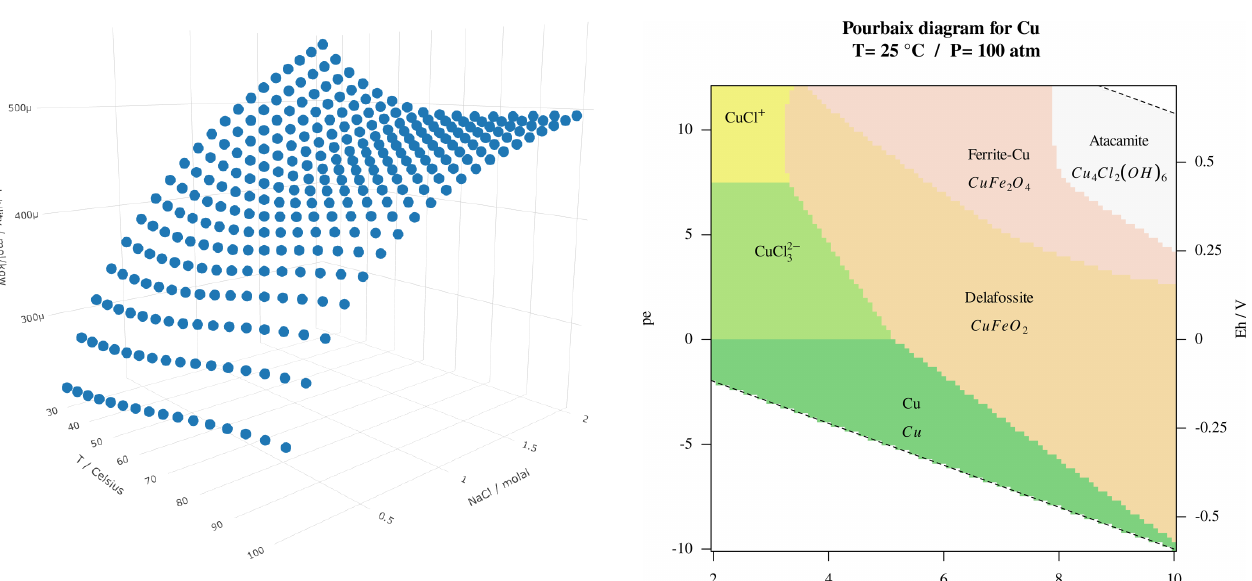
Figure 1. Screenshot of the interactive visualization of the results of the calcite solubility as function of T and salinity computed with Listing 8.